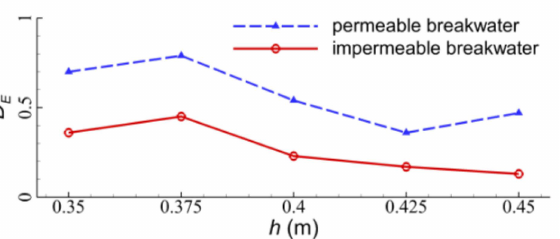
Figure 18. Variations in the total wave energy dissipation rate with the water depth.